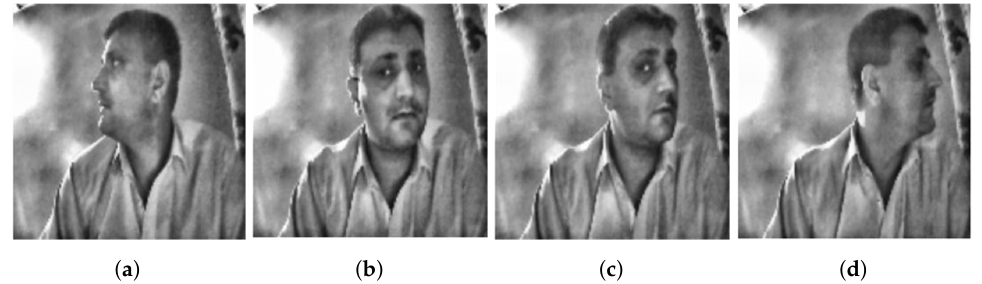
Figure 4. ( a – d ) Enhanced frames after the application of the CLAHE method.